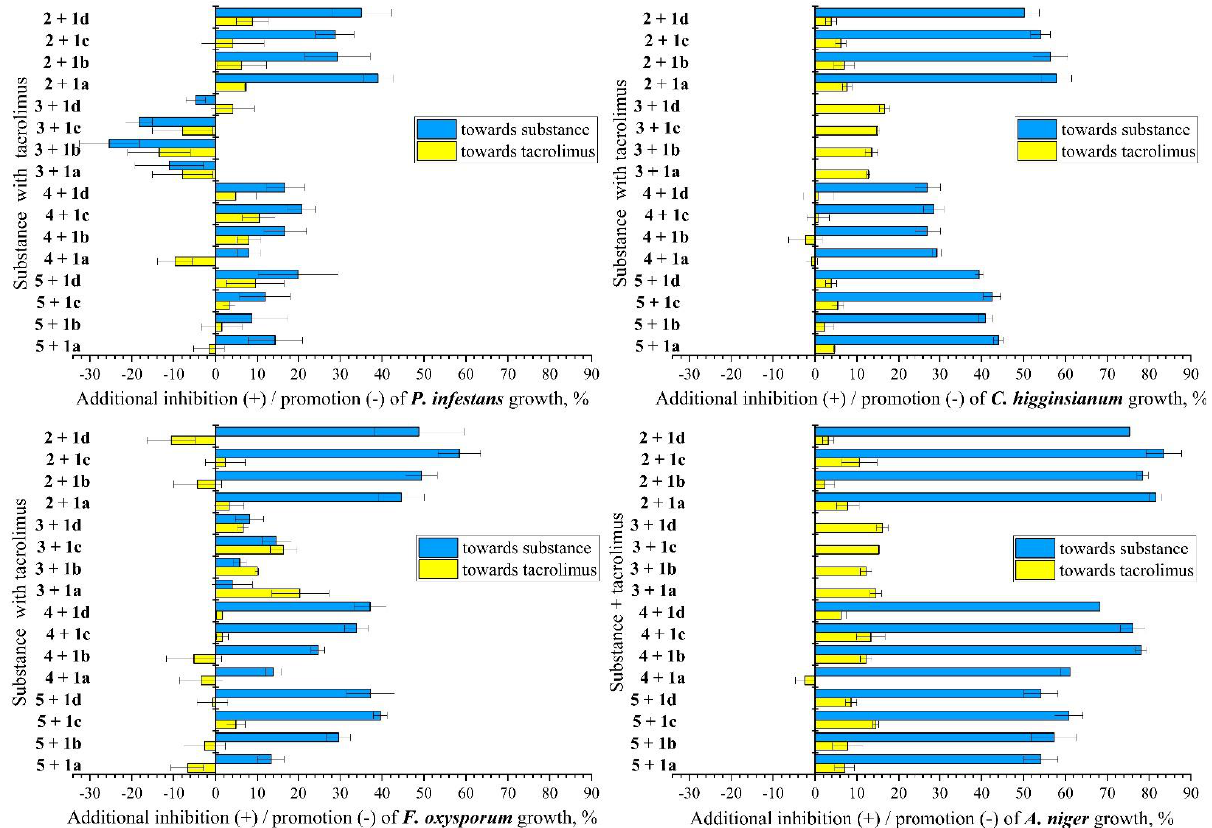
Figure 3. The additional growth inhibition (+)/promotion ( − ) of P. infestans , C. higginsianum , F. oxysporum , and A.niger was found, when tacrolimus ( 1a : 0.25 mg/L; 1b : 1 mg/L; 1c : 10 mg/L; 1d : 25 mg/L) was combined with hymexazol ( 2 ): 50 mg/L; cyproconazole ( 3 ): 25 mg/L; triazoles ( 4 ), and ( 5 ): 50 mg/L. Experiments were carried out in triplicate (error bars: standard deviation). Triazoles 4 and 5 showed medium additional inhibition rates in combination with tacrolimus. These effects were most distinct when applying 4 and 5 together with tacrolimus at 10 mg/L ( 1c ) to A. niger . An opposite impact on tacrolimus growth inhibition at the lower concentrations (0.25 mg/L; 1 mg/L) was observed in combination with triazole 4 against C. higginsianum ( − 0.78%; − 2.28%), F. oxysporum ( − 3.44%; − 5.13%), A. niger ( − 2.36%), and P. infestans ( − 9.61%). These findings may reflect a hormesis effect, i.e. a stimulation of response at low doses and inhibition of response at high doses [61,62]. Here, it can be caused by the induction of specific CYP isoforms that catalyze oxidative biotransfor- mation reactions of active substances [63]. An additional growth inhibition correlating with the tacrolimus concentration range (0.25 – 25 mg/L) was noted for F. oxysporum in combination with triazoles 4 or 5 . Notably, a strong significant ( p = 0.010 ) Spearman’s cor- relation coefficient of ρ = 1.000 between tacrolimus concentration and inh ibition level of triazole 4 against F. oxysporum was calculated. Correspondingly, it was calculated for tri- azole 5 at ρ = 0.900 ( p = 0.037). Considering the physico-chemical parameters of the studied triazoles, the number of rotational bonds conferred the highest influence on the antifungal activities, with a strong Spearman’s rho of 0.872 , significant at the level of p =.054 (Supple- mentary Material Table S9) [64].